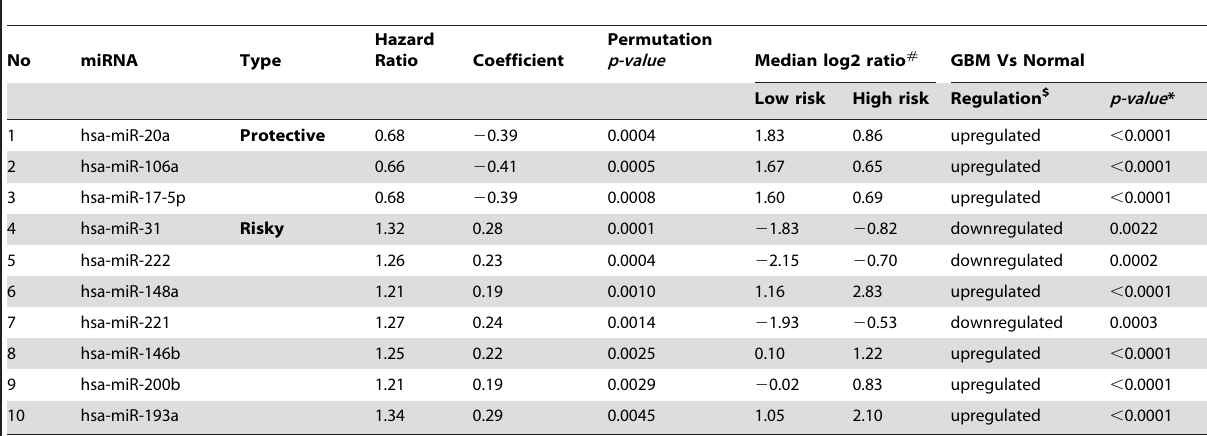
# Median of the log 2 transformed ratios of GBM vs Normal. $ type of regulation (upregulated or downregulated) in GBM in comparison to Normal. *Two-tailed p-value obtained from Mann-Whitney test.